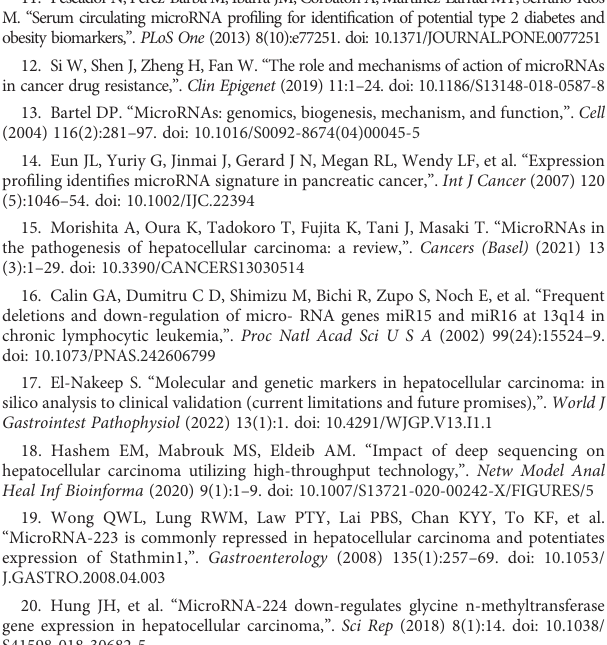
SUPPLEMENTARY FIGURE 1 BCLC Barcelona Clinic Liver Cancer, PS performance status, N node classi fi cation, M metastasis classi fi cation, RFA radiofrequency ablation, TACE transcatheter arterial chemoembolization. https://www.researchgate.net/